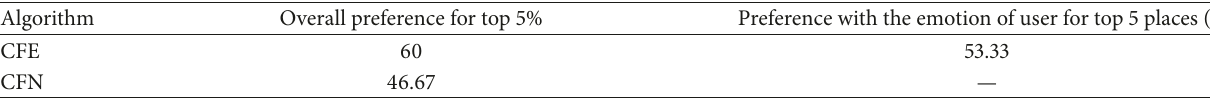
Table 8: User satisfaction for top-five-places